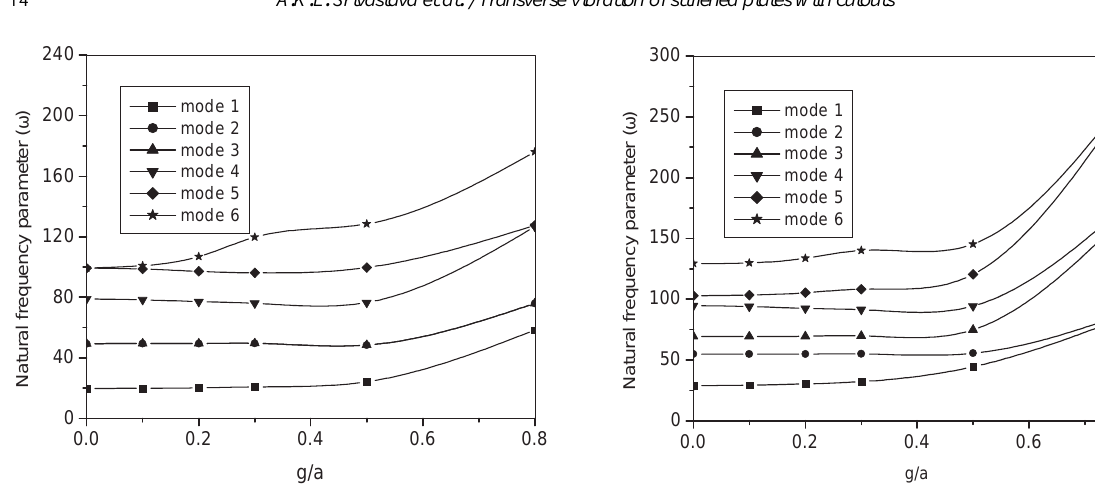
Fig. 6. As Fig. 4, but for CSCS boundary condition.